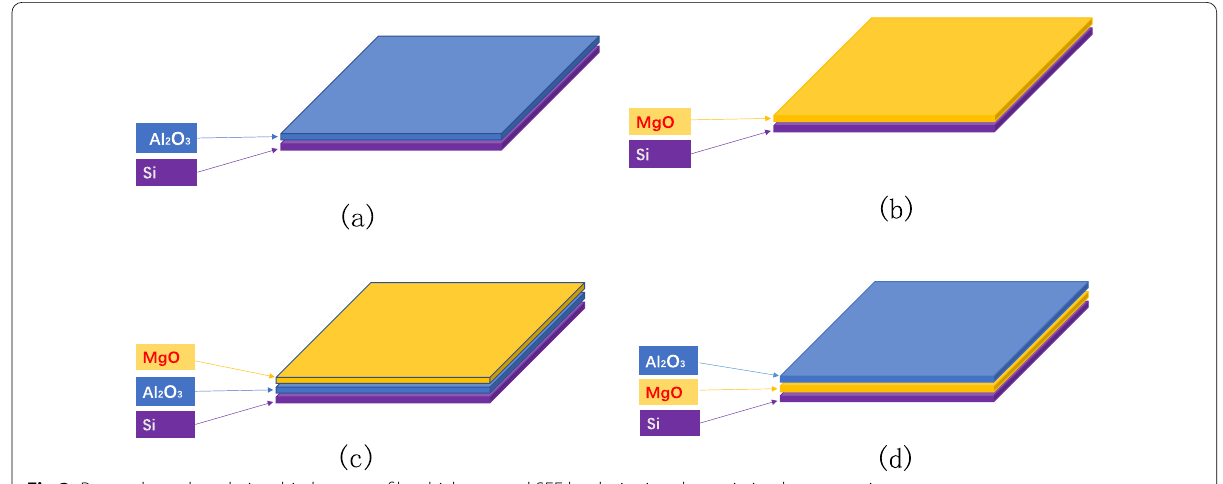
Fig.3 Research on the relationship between film thickness and SEE by designing the emission layer experiment